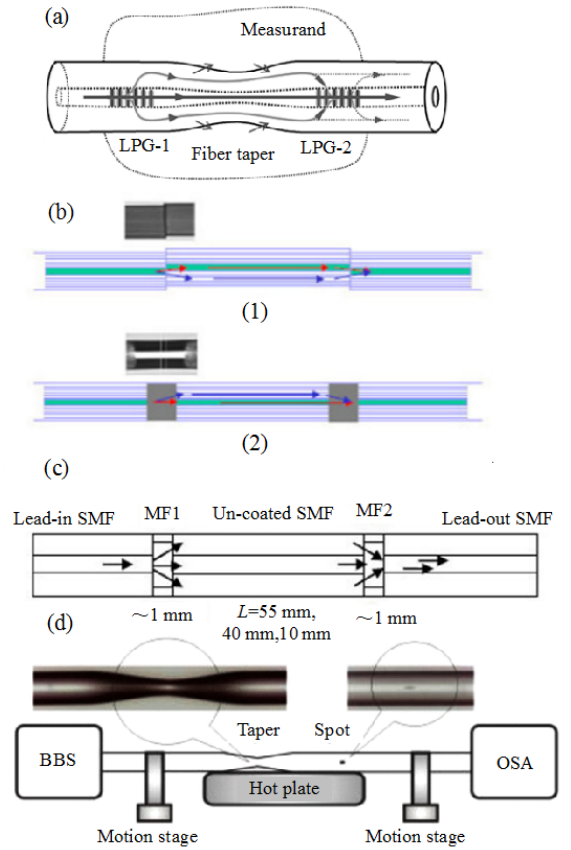
Fig. 21 Schematic diagrams of the mode field mismatch based MZI formed by (a) LPFG [139], (b) offset splicing [141], (c) core-mismatching [142], and (d) taper fiber